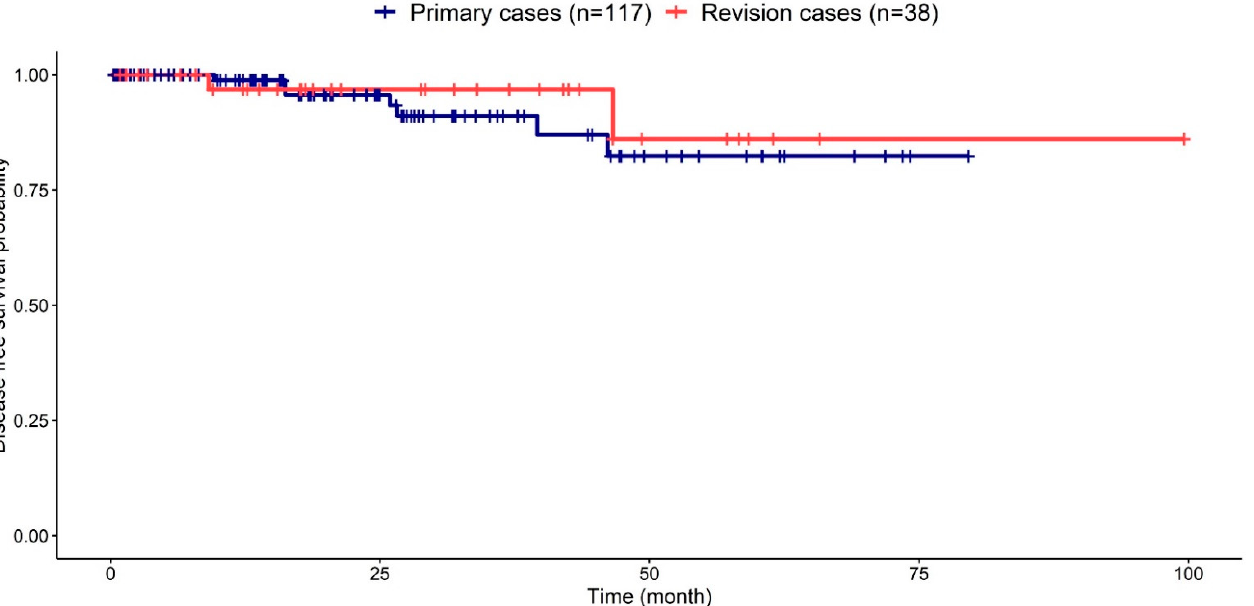
Figure 4. Kaplan–Meier plot for primary and revision cases. There were seven and two recurrences in primary and revision cases, respectively. There was no significant difference in recurrence rates between the two groups ( p = 0.600, log-rank test).